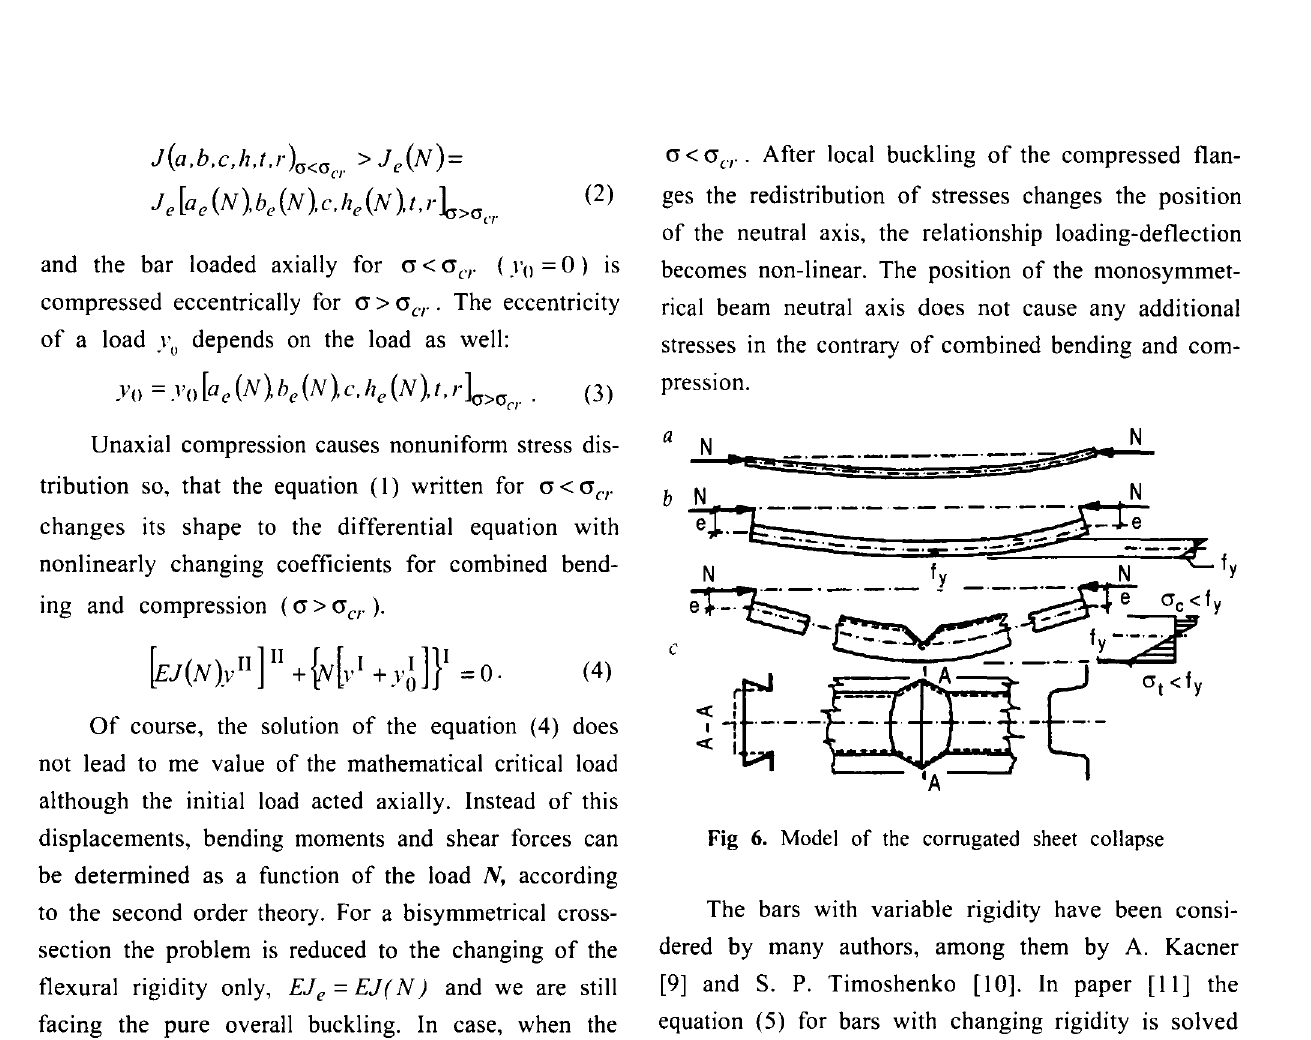
Fig 6. Model of the corrugated sheet